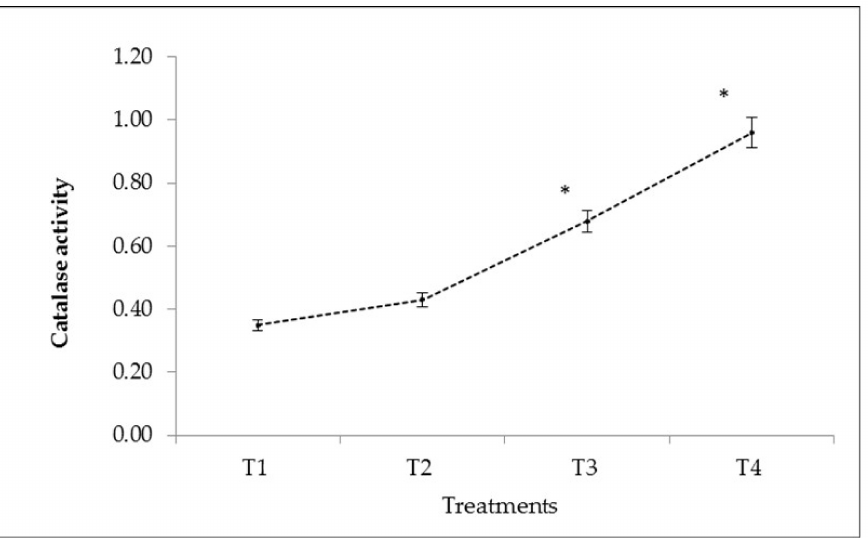
Figure 3. The effect of mineral fertilisers on catalase activity of irrigated soil in Kibray district, Tashkent Region, Uzbekistan. ( p values showing significantly different at p < 0.05 * as compared to control (T1)). Bars represent ± SD